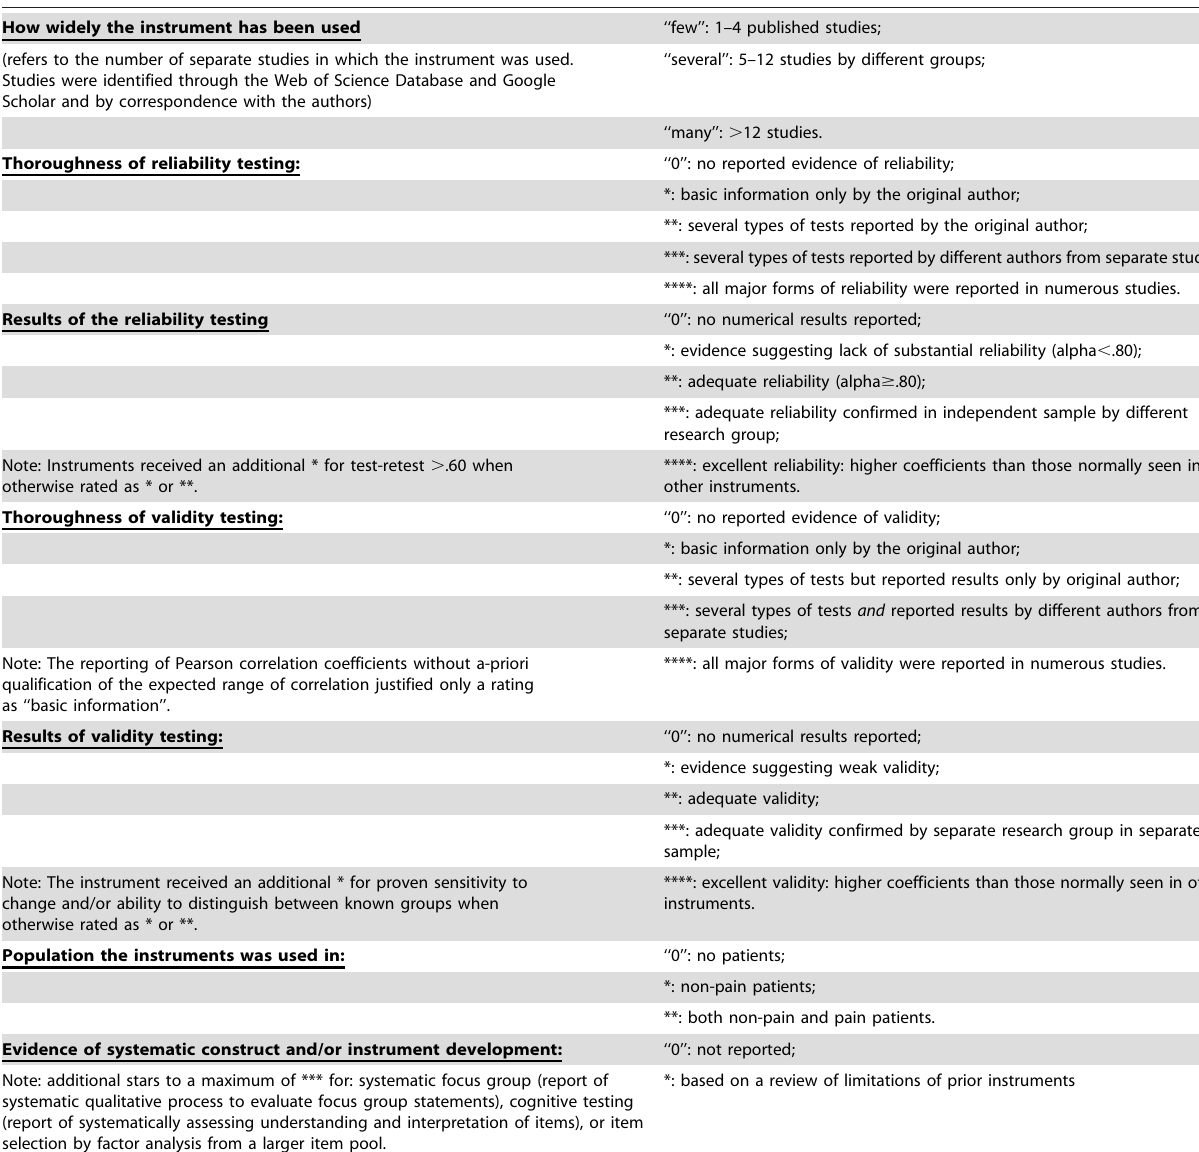
Table 3. Criteria for Reliability and Validity Rating (modified after McDowell,